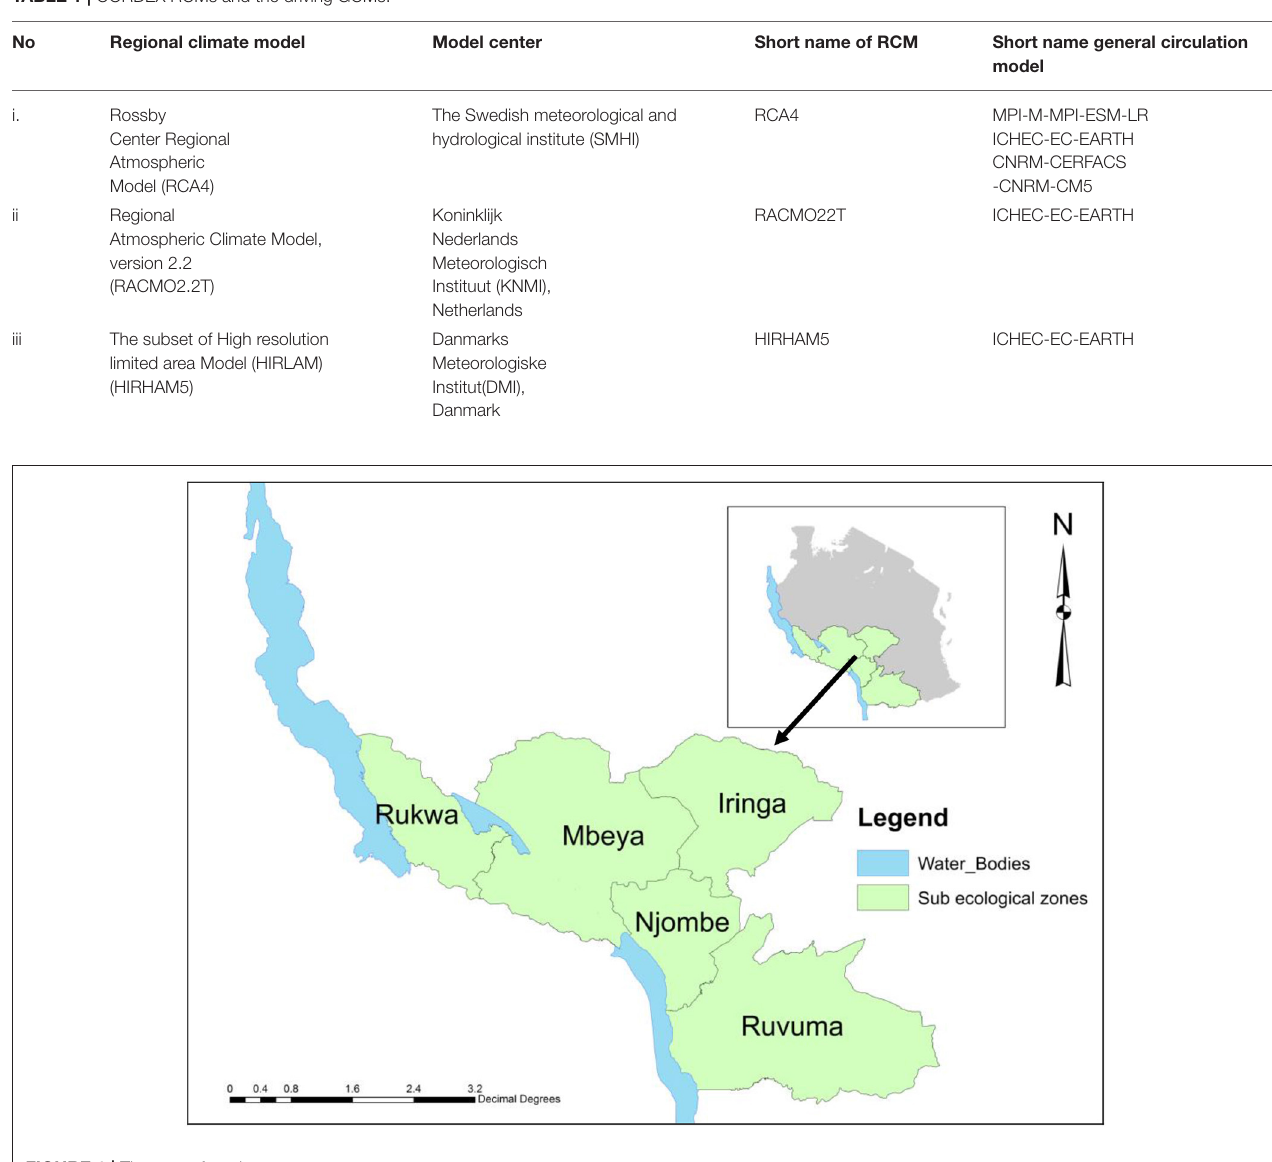
FIGURE 1 | The area of